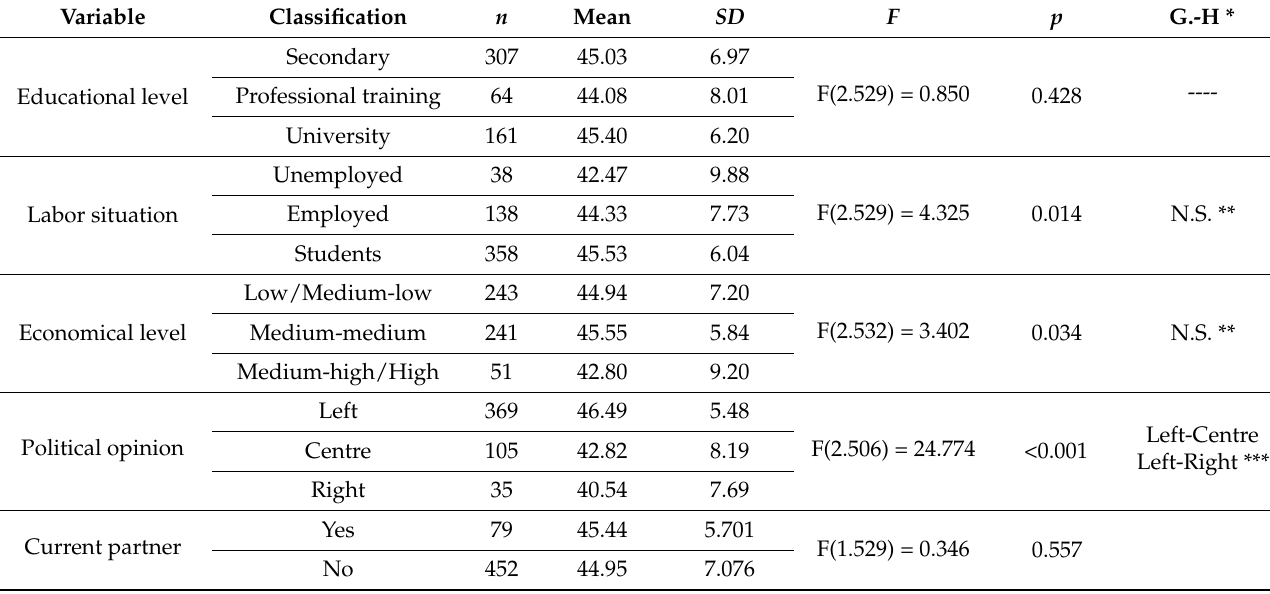
Table 7. Attitudes toward “piropos” and other socio-demographic